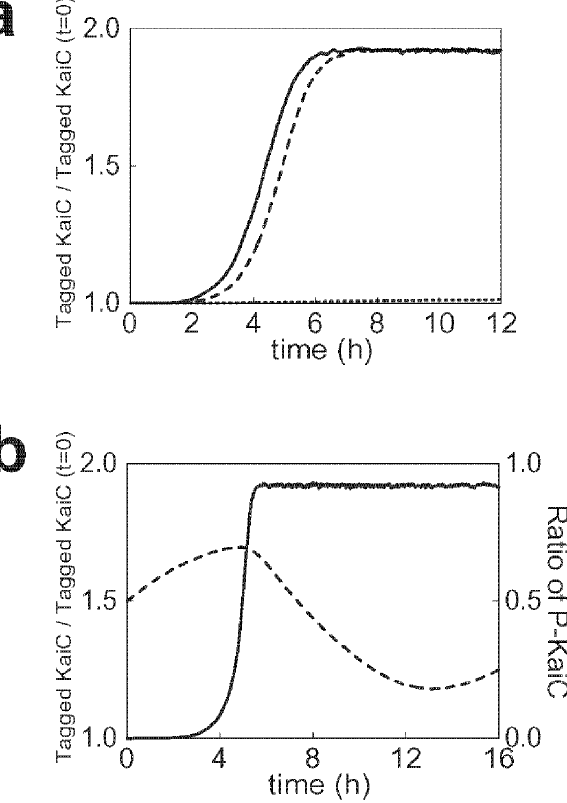
Figure 8.Monomer shuffling between KaiChexamers. (a) KaiChexamers composed of tagged monomers and those composed of untagged monomers were mixed in the ratio of 1:1 in the absence of KaiA or KaiB (real line), in the presence of KaiB (dashed line), or in the absence of KaiA (dotted line). The amounts of tagged KaiC hexamers normalized by its initial amount are shown. (b) The phosphorylation level p ( t ) (dashed line) and the amount of tagged KaiC hexamers normalized by its initial amount (solid line) in the presence of KaiA and KaiB.